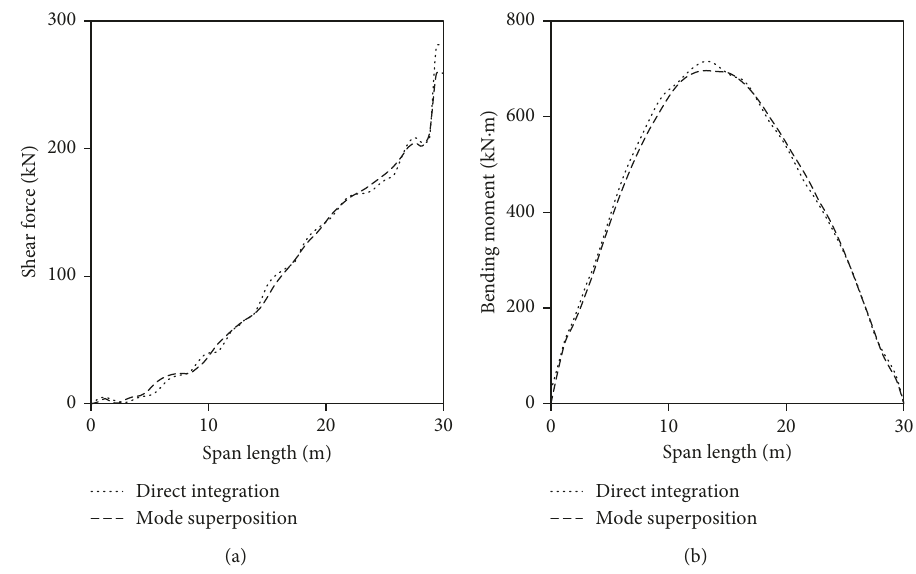
Figure 5: Comparison of different dynamic analysis methods for Bridge A-4. (a) Shear force; (b) bending moment.